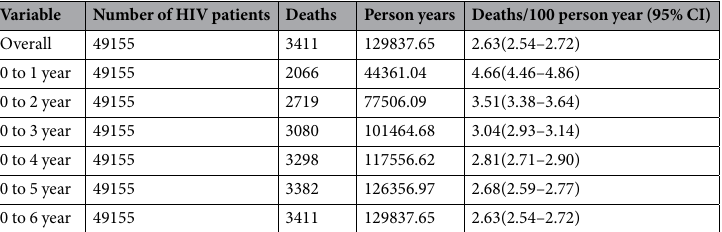
Table 2. Mortality rates in HIV-infected patients who started ART between 2010 and 2015 in Guangxi, China, by year post-ART